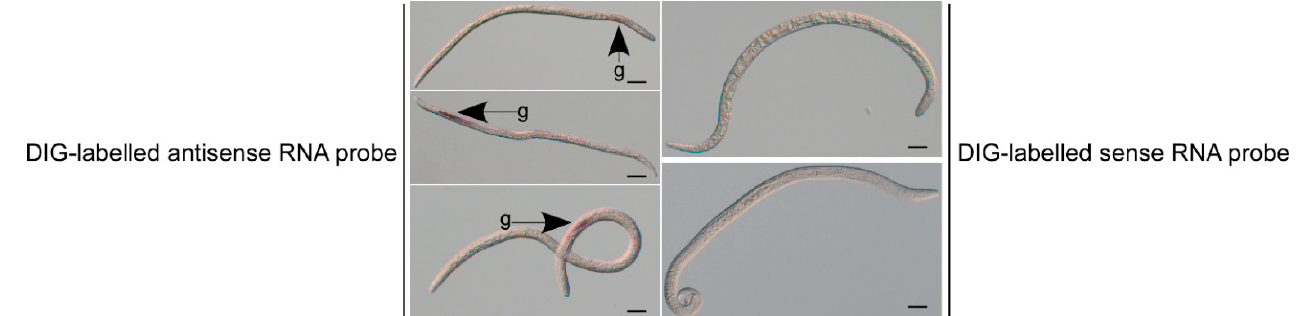
Figure 1. Localization of BxTTR-52 in the dorsal glands by in situ hybridization. The scale bars = 20 µm.